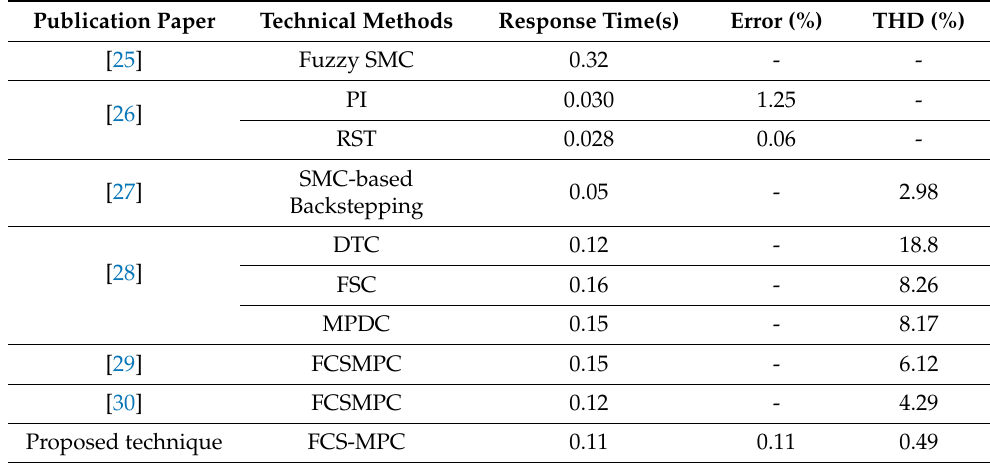
Table 2. Performance’s